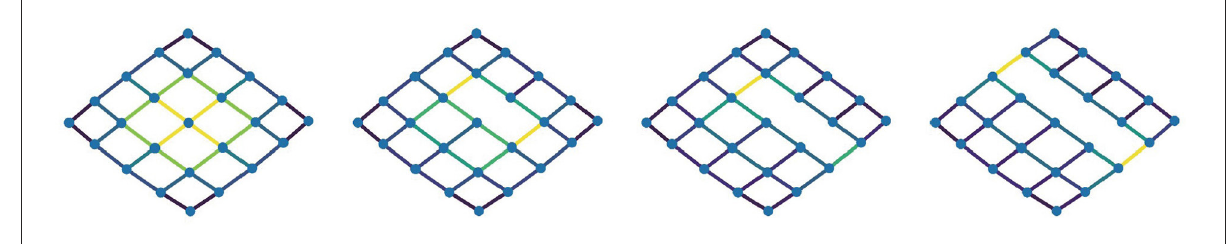
FIGURE2 Network topology-based free spread model illustration (yellow: infected edge; green: travel path).